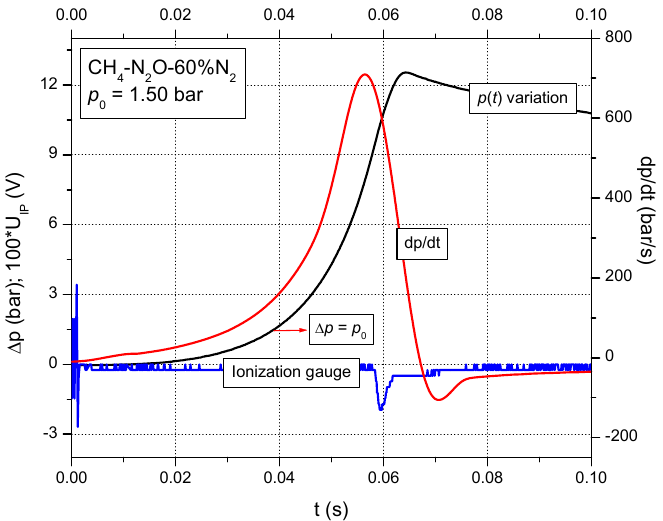
Figure 3. Pressure variation during the explosion in stoichiometric CH 4 -N 2 O-60% N 2 , at ambient initial temperature and p 0 = 1.50 bar.